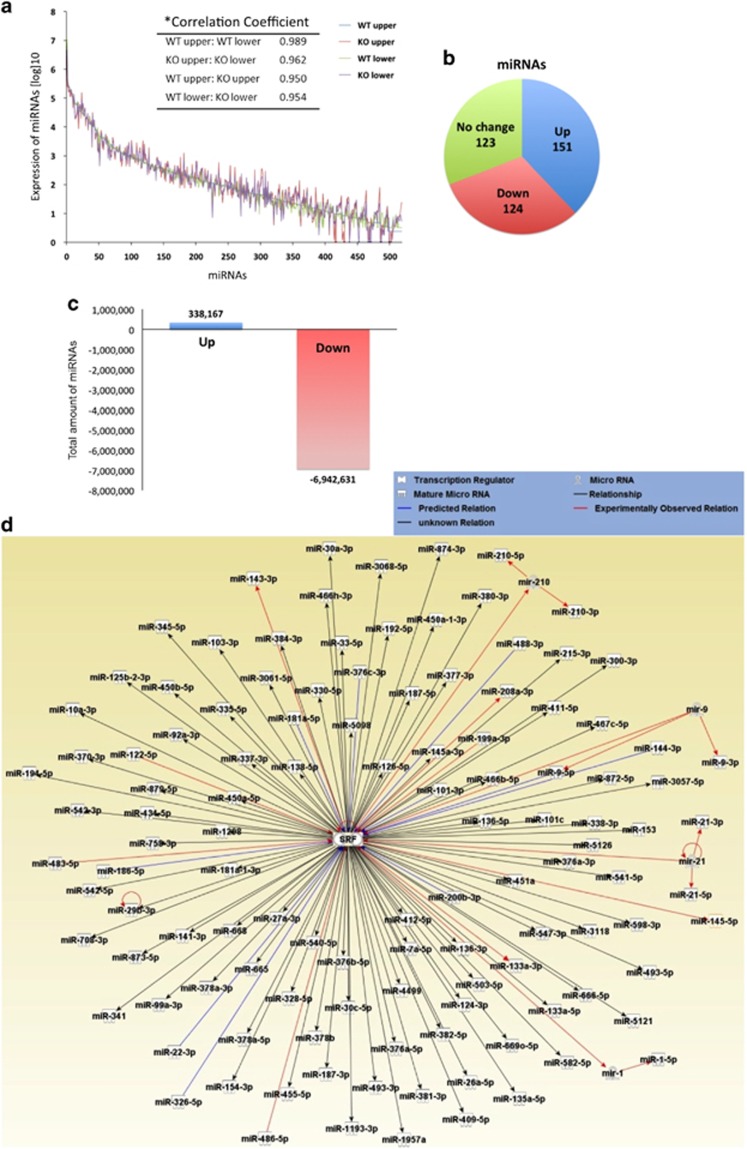
Identification of dysregulated miRNAs in the KO smooth muscle. MiRNA-seq analysis of KO upper and lower jejunum along with WT controls identified 892 miRNAs. After filtering by expression levels, 519 miRNAs were used for further analysis. (a) Expression profile of miRNAs identified in WT and KO smooth muscle. (b) Number of dysregulated miRNAs. (c) Comparison of total dysregulated miRNAs between WT and KO. (d) Pathway analysis of SRF-dependent miRNAs. Interactions between upregulated miRNAs and SRF were analyzed using IPA software